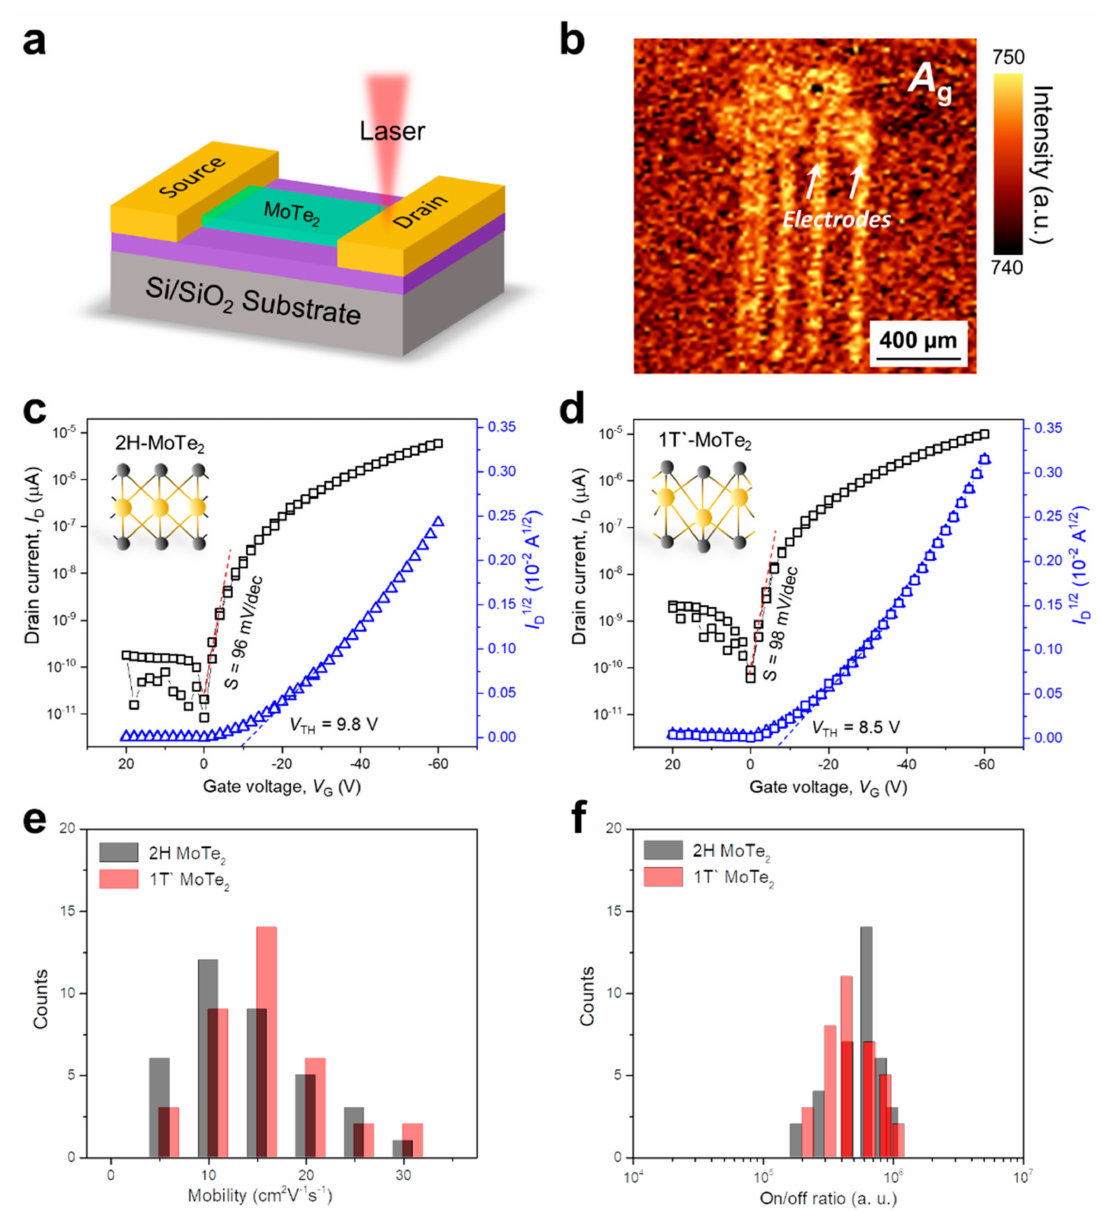
Figure 2. Electrical characterization of 2H and 1T (cid:48) -phase of MoTe 2 FETs: ( a ) Schematic structure of MoTe 2 FETs on SiO 2 /Si substrate; the dimensions of the MoTe 2 FETs are the following: channel length 20 µ m and width 400 µ m. ( b ) Two- dimensional A g Raman mapping image of MoTe 2 FETs on SiO 2 /Si substrate after laser irradiation. Transfer curves of ( c ) 2H MoTe 2 and ( d ) 1T (cid:48) MoTe 2 FETs after laser irradiation; ( e ) Statistical diagram of the measured carrier mobilities; ( f ) On/off ratio of the 36 fabricated 2H and 1T (cid:48)